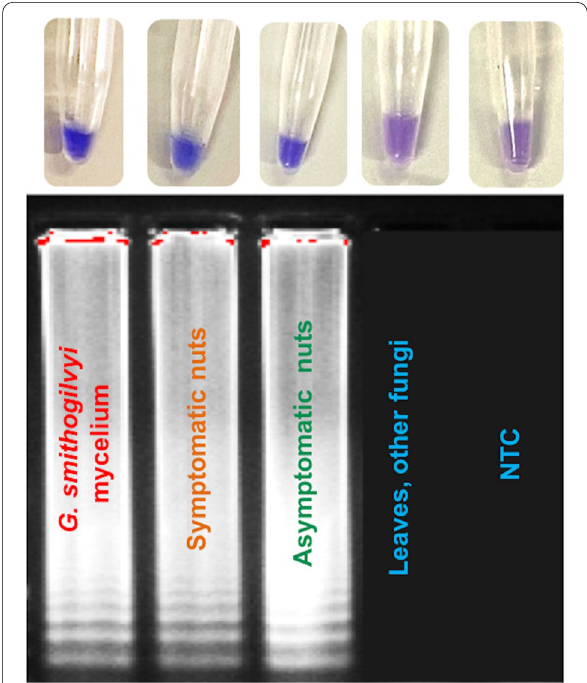
Fig. 3 Visual detection of LAMP products (V-LAMP) by single-tube colorimetric reaction and electrophoretic gel. Representative visual inspection of Gnomoniopsis smithogilvyi from different plant tissues and mycelium. NTC No Template Control. The assessment for the = V-LAMP assay was based on the HNB color change visualization of the LAMP products (Positive samples blue color change in reaction; = negative samples purple color =